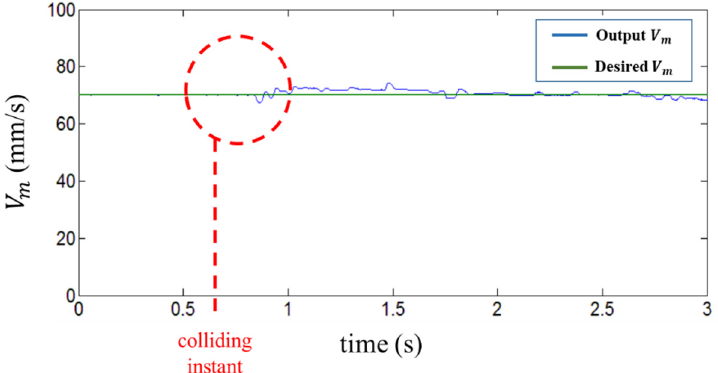
Figure 6. Output and desired velocities of steel plate during rolling.